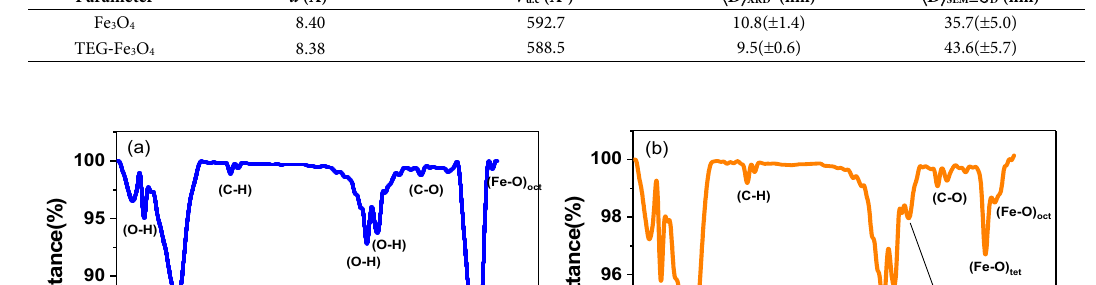
) obtained by Rietveld refinement. Average crystallites size 〈 D 〉 u.c by using Eq. 1, and mean aggregates size 〈 D 〉 by FESEM images. SEM